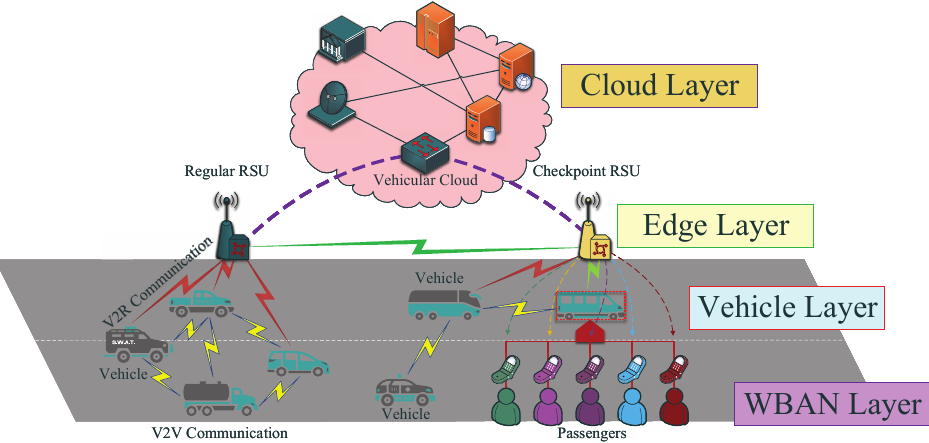
Figure 1. Cloud-Assisted VANET System